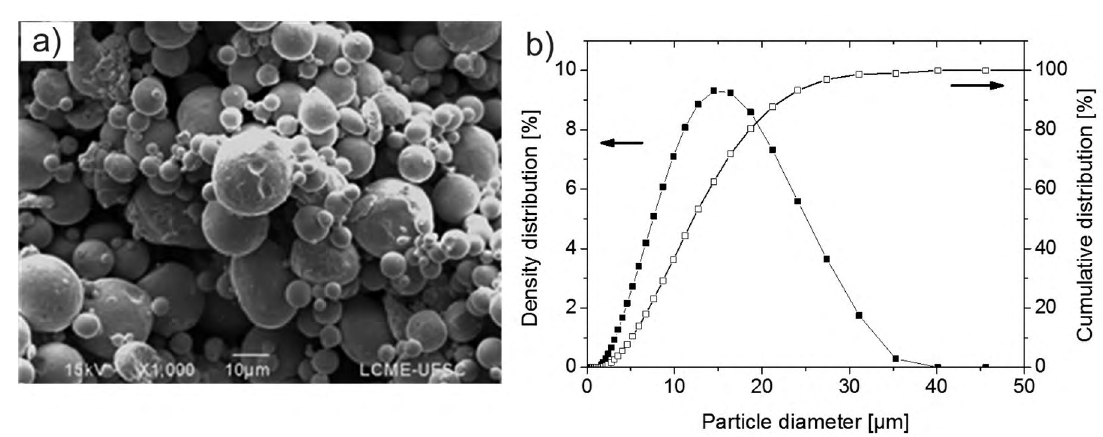
Figure 1. Starting powder a) SEM showing the particle morphology and b) particle size